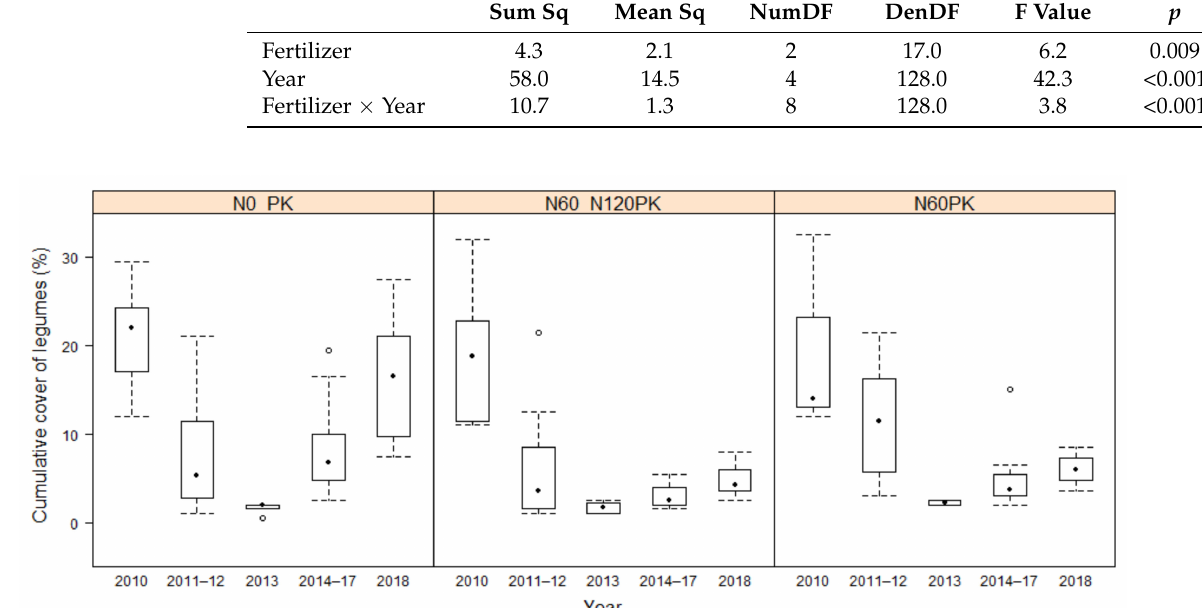
Figure 6. The minimal adequate model for the effect of fertilization treatment and time on the cumulative cover of legumes with different fertilization treatments between 2010 and 2018 (except